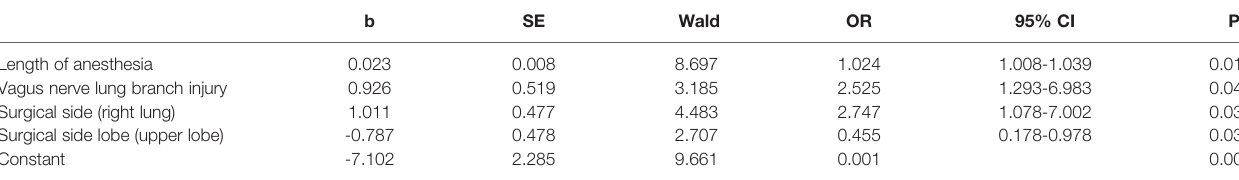
TABLE 6 | Binary logistic regression analysis of CAP. b SE Wald OR 95% CI P Length of